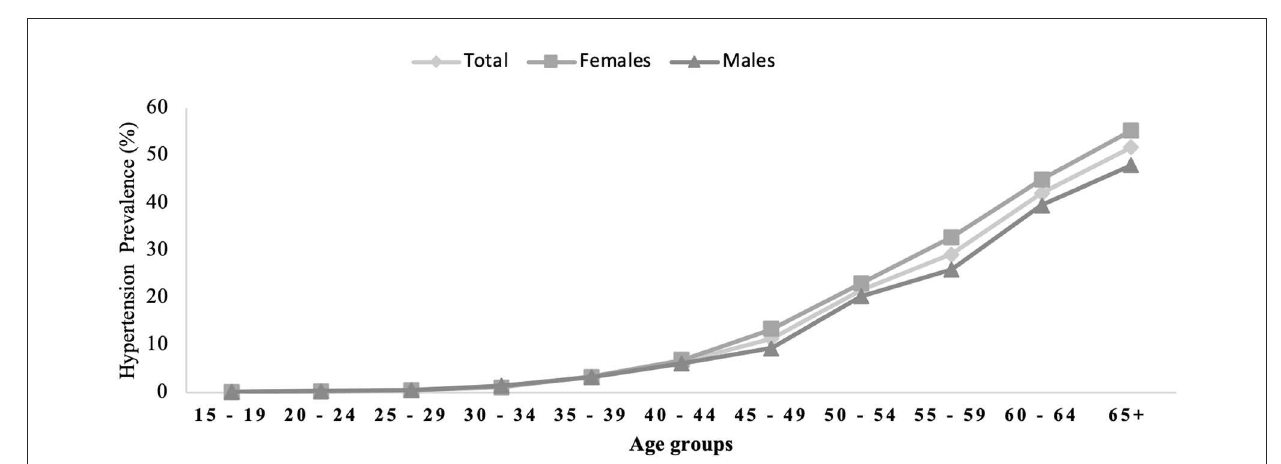
FIGURE2 Hypertension prevalence across gender and age